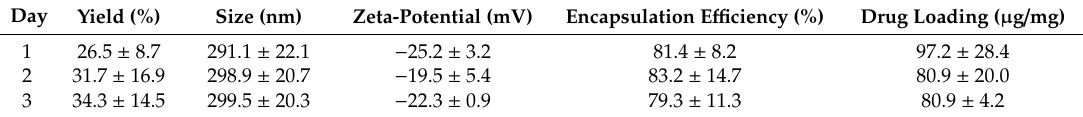
Table 2. Inter-day evaluation for physical properties of optimized formulation (n = 3).